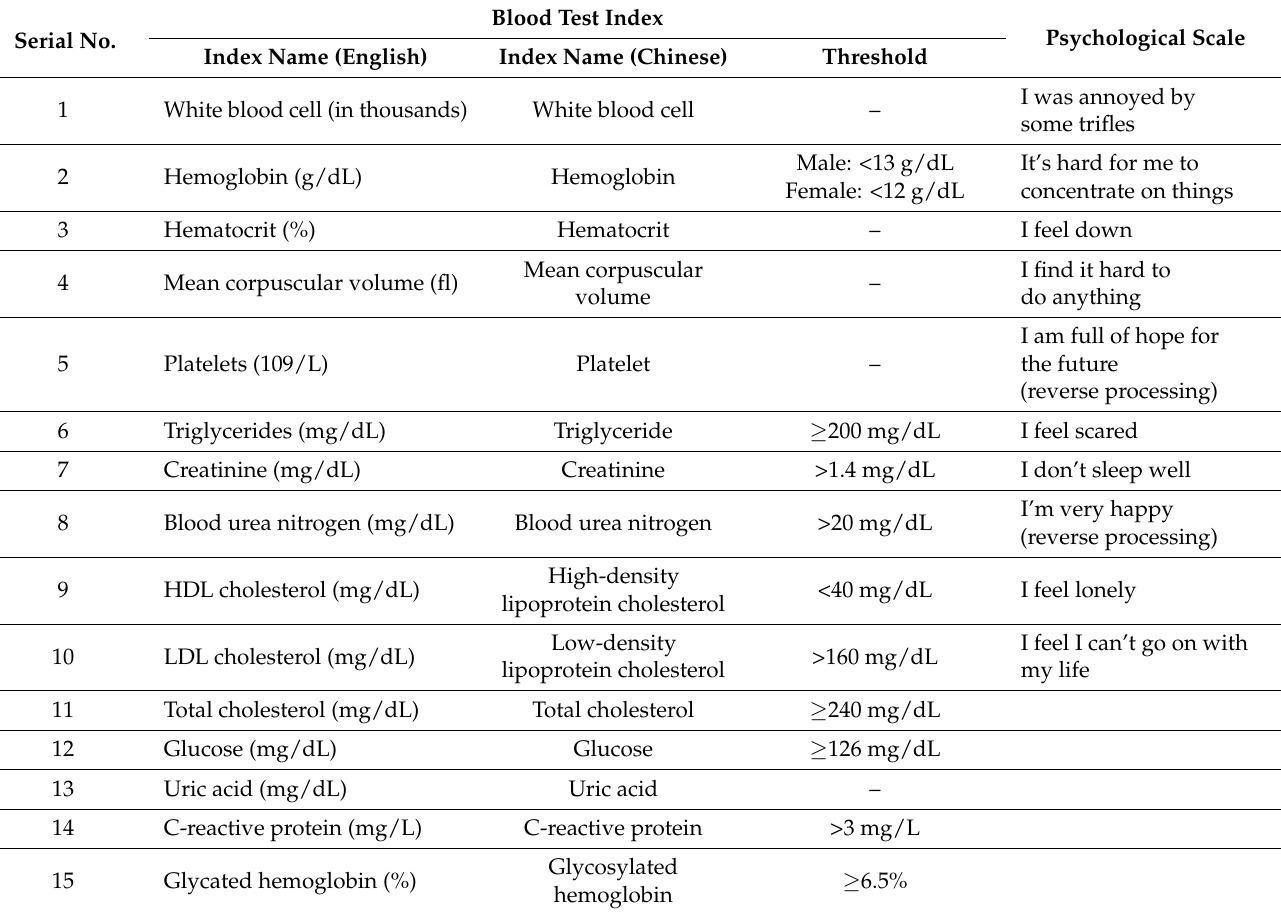
Table 2. Blood test indicators and psychological scale.